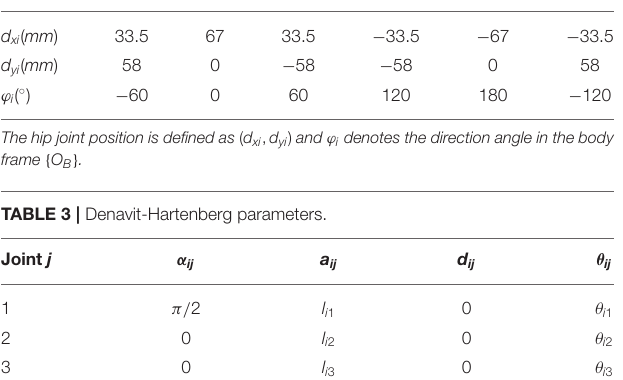
O i 0 O B to the . { } { }